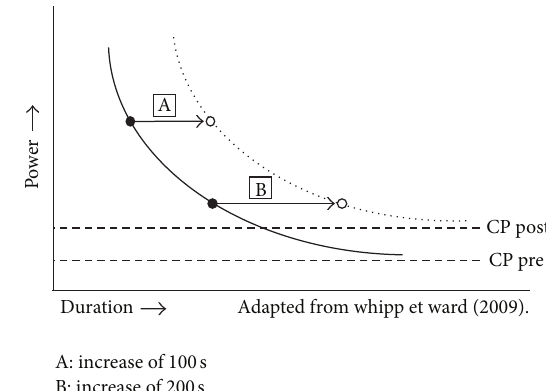
Figure 1: The impact of the power/duration relationship on the exercise endurance response following an intervention. With CP: critical power pre- or postintervention, considered as the asymptote of the power/duration